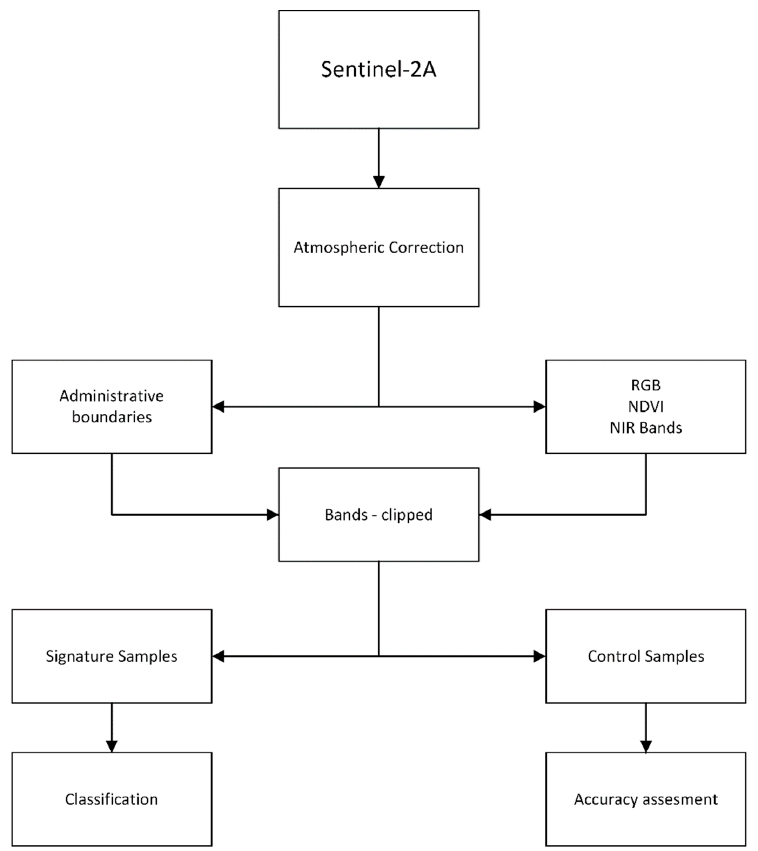
Figure 2. The workflow process. NDVI, normalized difference vegetation index; NIR, near ‐ infrared.